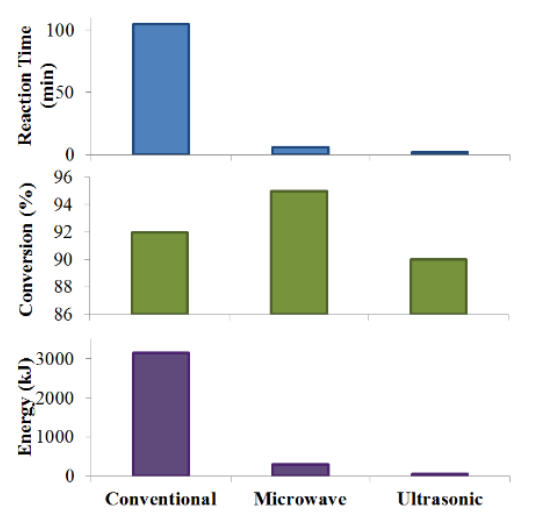
Figure 4. Comparison of waste cooking oil conversion by conventional/non-conventional methods